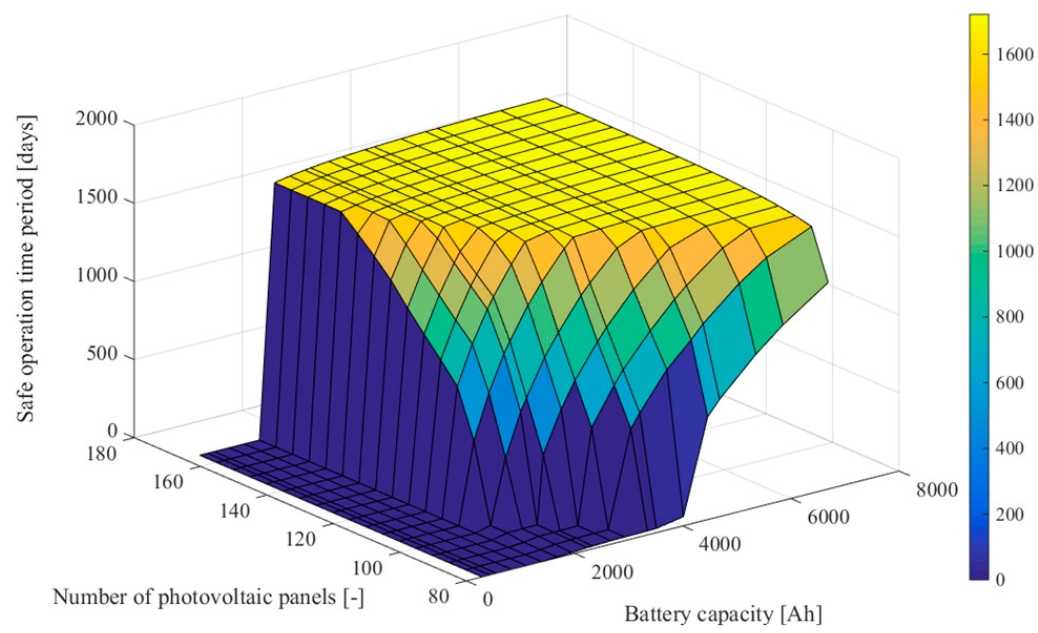
Figure 13. Battery economic lifetime for the SAPV system with respect to the capacity of the 110 V gel RES SOPzV battery system (see Table 7) and PV population (80, 85, …, and 165).